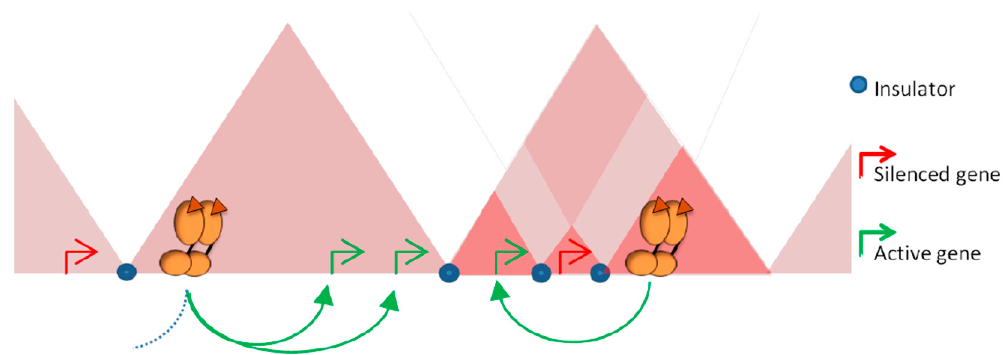
Figure 3. Structural segmentation of the genome restrains the range of action of regulatory elements. The enrichment in proteins with insulator function at the borders between TADs can prevent contact with regulatory elements activated by steroid receptors with promoters located outside of the domains. The natural tendency of contacts within a TAD limits the space to be explored by an activated enhancer and favor the stability of promoter-enhancer contacts within the domain independently of the genomic distance. Intra-domain loops established in a cell specific manner can serve to isolate genes from the activity of distal regulatory elements or conversely, favor contacts between enhancers and specific sets of genes.